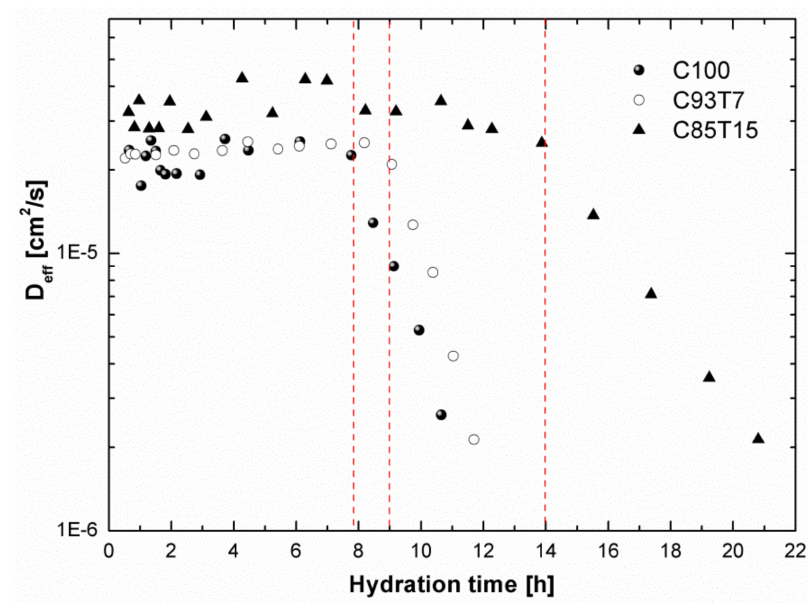
Figure 9. Self-di ff usion coe ffi cient, D e ff versus hydration time obtained from NMR data by using Equations (5)–(7). The time at which D e ff has decreased depends on the TiO 2 concentration. For the 15% TiO 2 sample, this started at a longer time compared to the other